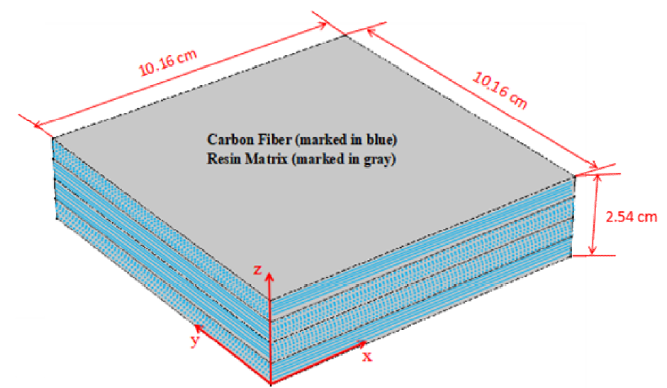
Figure 2. Schematic of the composite laminates. Materials 2019 , 12 , x FOR PEER REVIEW